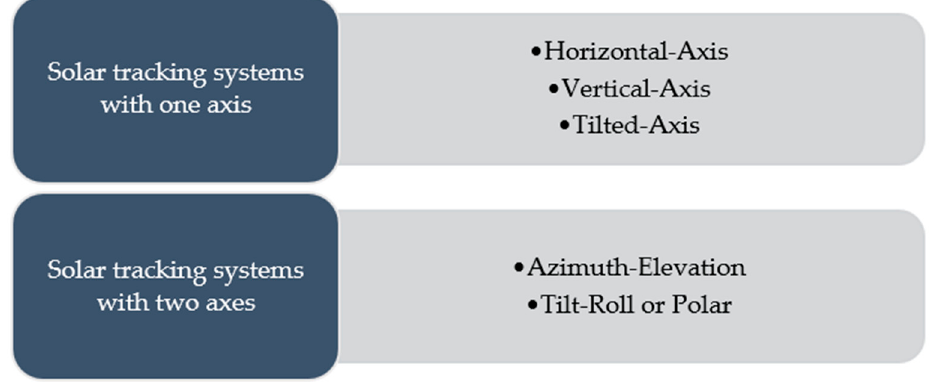
Figure 2. Types of sun tracker solutions based on [36].